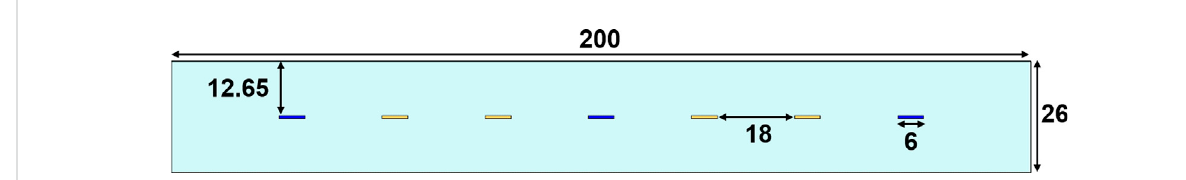
FIGURE 8 Front view of seven striplines.